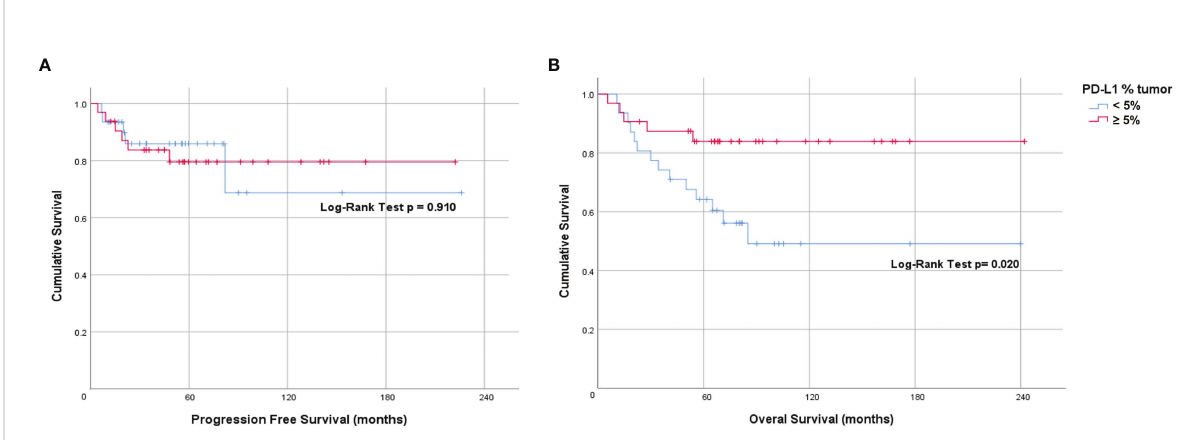
FIGURE 2 Prognostic value of tumor PD-L1 expression in anal cancer. Kaplan-Meier plots indicating (A) Progression-free survival and (B) Overall survival of patients strati fi ed by tumor PD-L1 ≥ 5%.